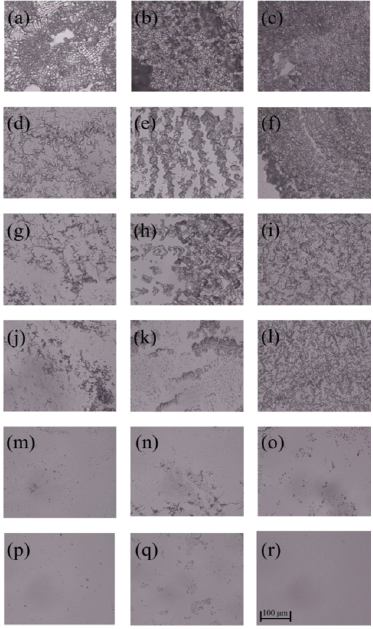
Figure 8. The inhibitory effect of AG-GT-2 on S. aureus biofilms: ( a – c ) are the S. aureus biofilms de- veloped for 1, 3 and 5 days in control group, ( d – f ) are the S. aureus biofilms treated with AG-GT-2 at a concentration of 1/4 MIC for 1, 3 and 5 days, ( g – i ) are the S. aureus biofilms treated with AG- GT-2 at a concentration of 1/2 MIC for 1, 3 and 5 days, ( j – l ) are the S. aureus biofilms treated with AG-GT-2 at a concentration of MIC for 1, 3 and 5 days, ( m – o ) show the S. aureus biofilms treated with AG-GT-2 at a concentration of 2 MIC for 1, 3 and 5 days, ( p – r ) present the S. aureus biofilms treated with AG-GT-2 at a concentration of 4 MIC for 1, 3 and 5 days, respectively.